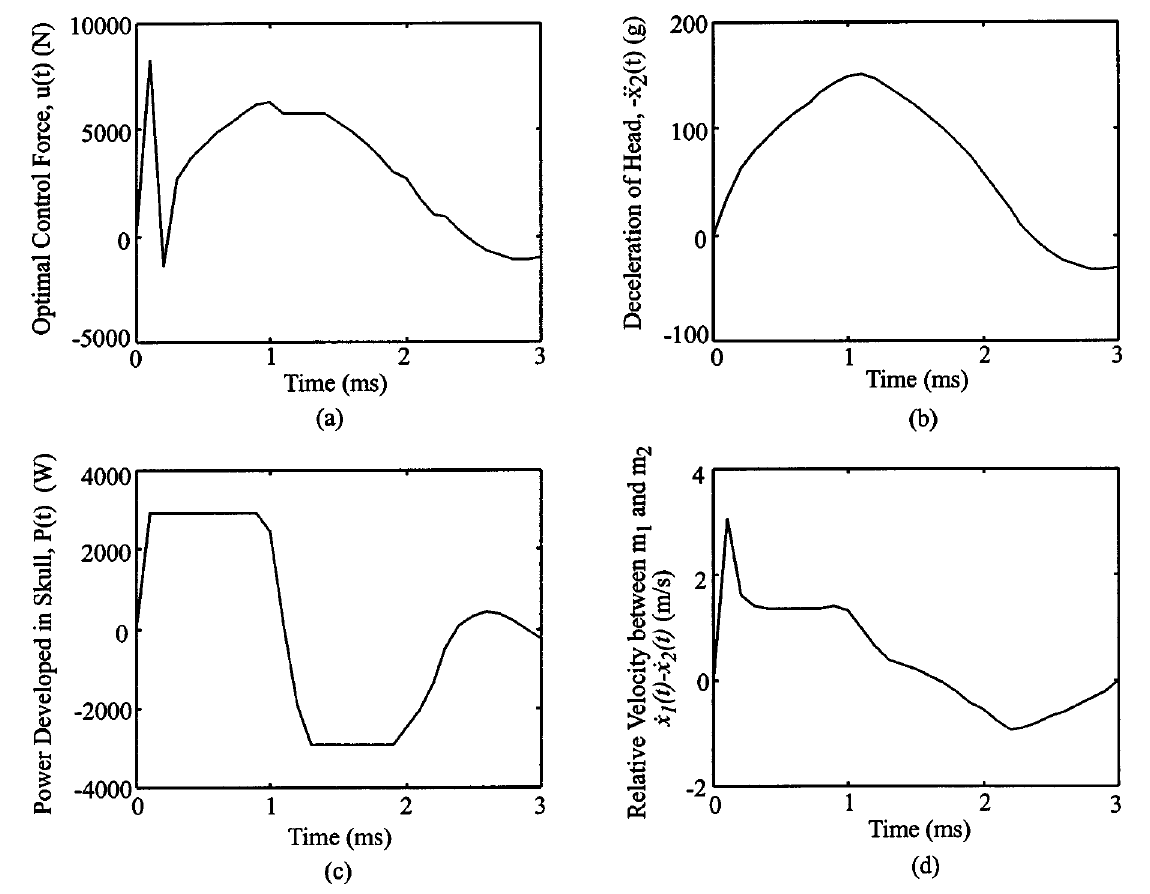
Fig. 18. Time histories of the optimal control force and the system responses. Case 3: Minimization of the peak power developed in the skull, L–R direction, S 0 = 10 mm, T 0 = 1 ms, v 0 = 36 : 4 m/s.